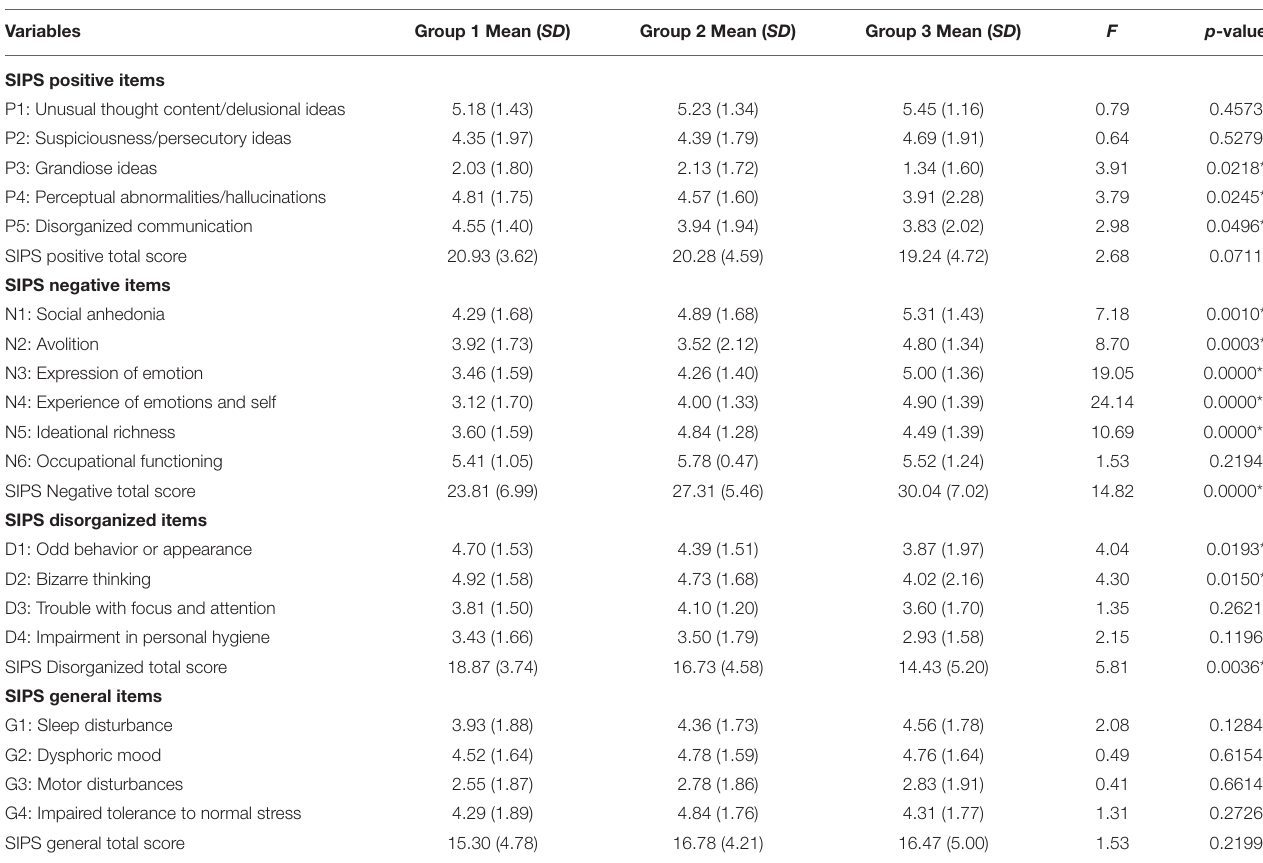
TABLE 4 | Group differences on